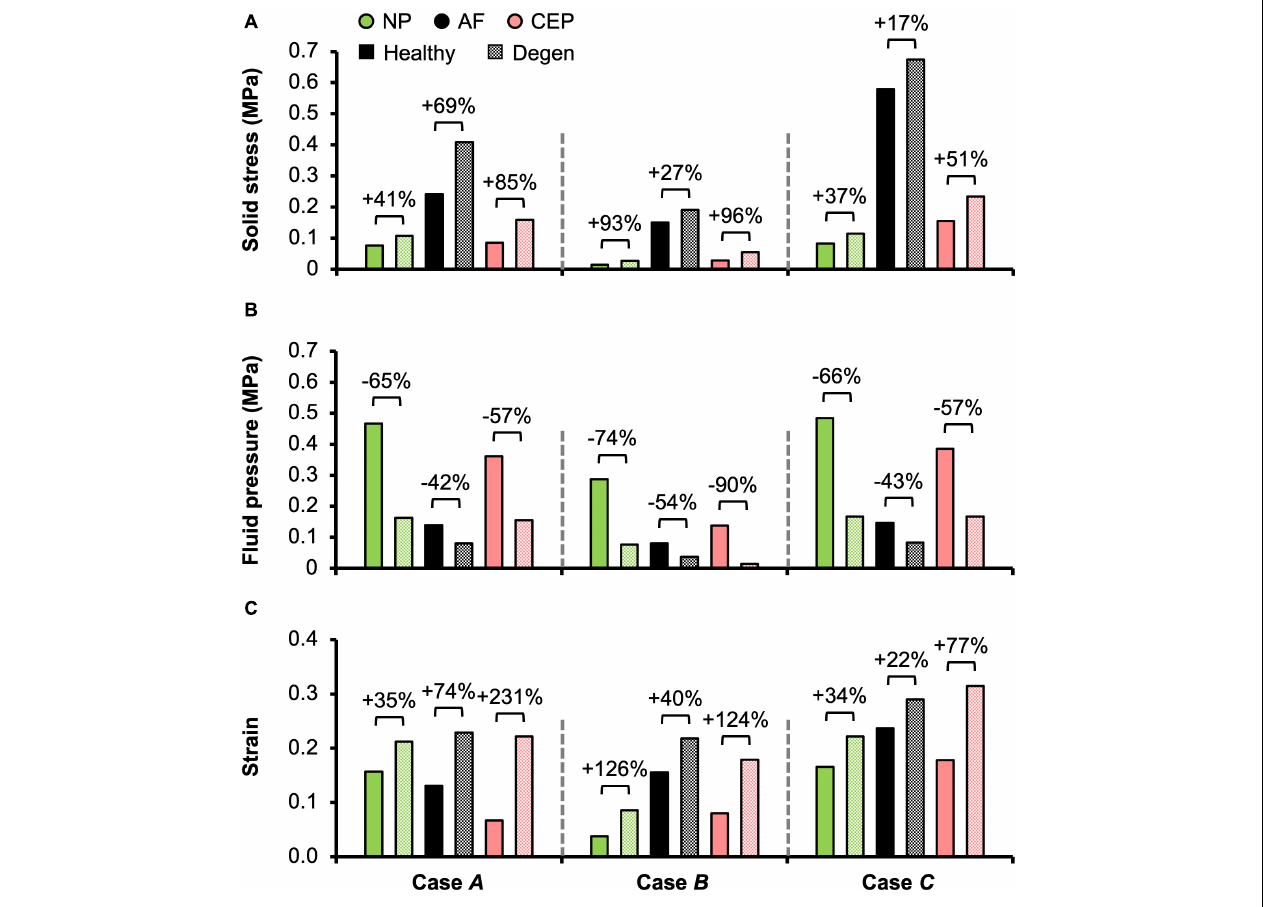
FIGURE 7 | Model-predicted post-loading average (A) solid stress, (B) fluid pressure, and (C) strain in the nucleus pulposus (NP), annulus fibrosus (AF), and cartilage endplate (CEP) in healthy and degenerated (Degen) disc models. Relative changes in NP, AF, and CEP solid stress, strain, or fluid pressure with degeneration are labeled above corresponding neighboring